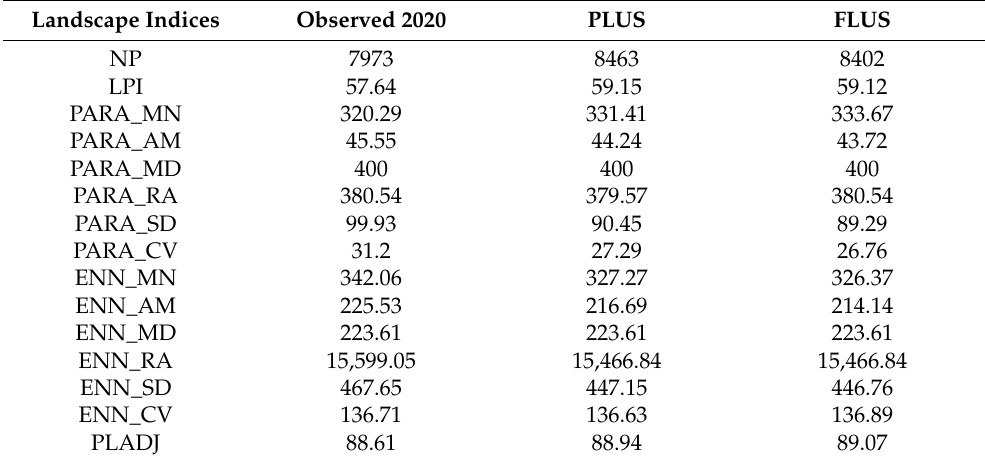
Table 10. Landscape similarity of the simulation results in the ECA of western Beijing in 2020. Landscape